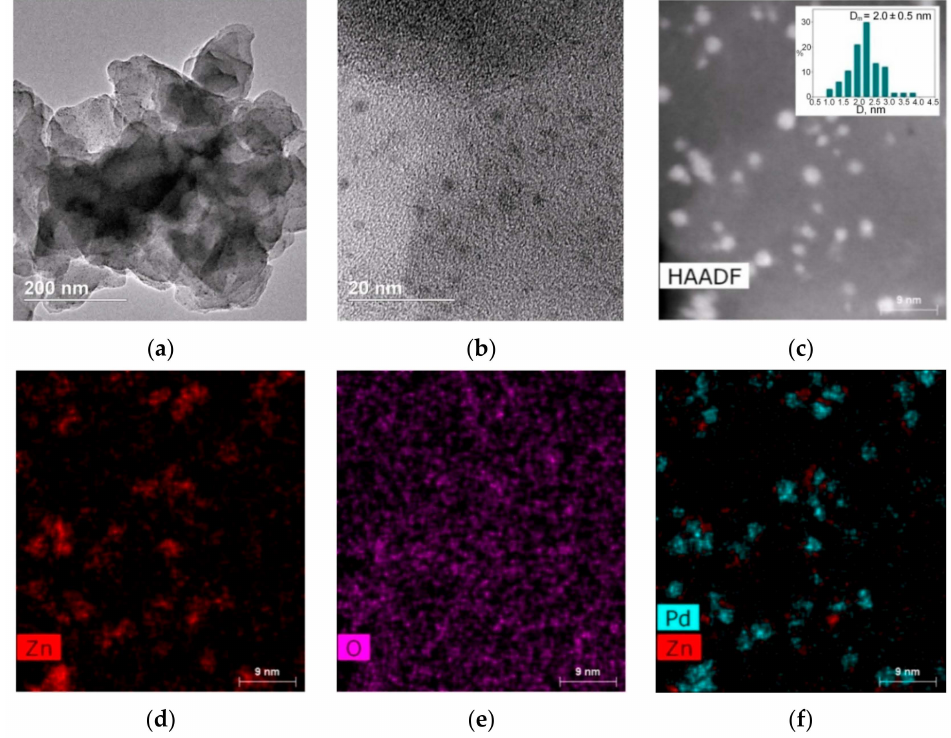
Figure 6. Bright-field ( a , b ) and dark-field ( c )(scale 9 nm) STEM images of the reduced sample 1%-PdZn/HPS-R and EDX mapping of the Zn ( d ), O ( e ), and Zn-Pd superposition ( f ) (scales 9